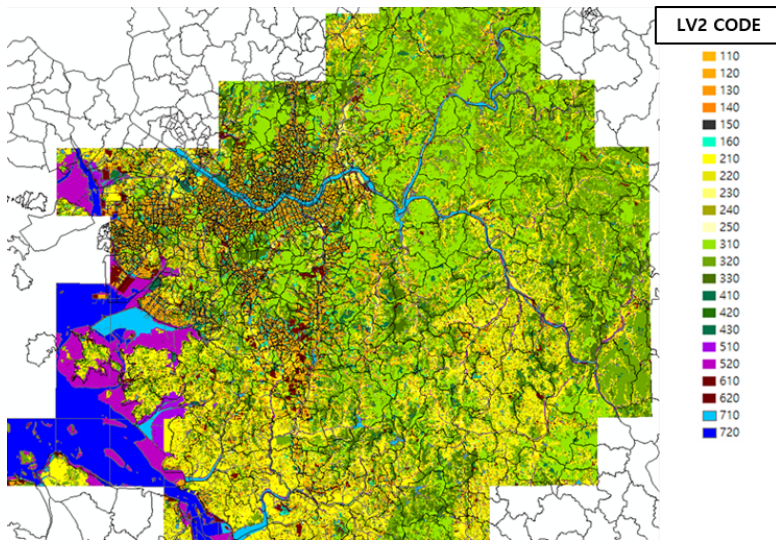
Figure 3. Land cover map of